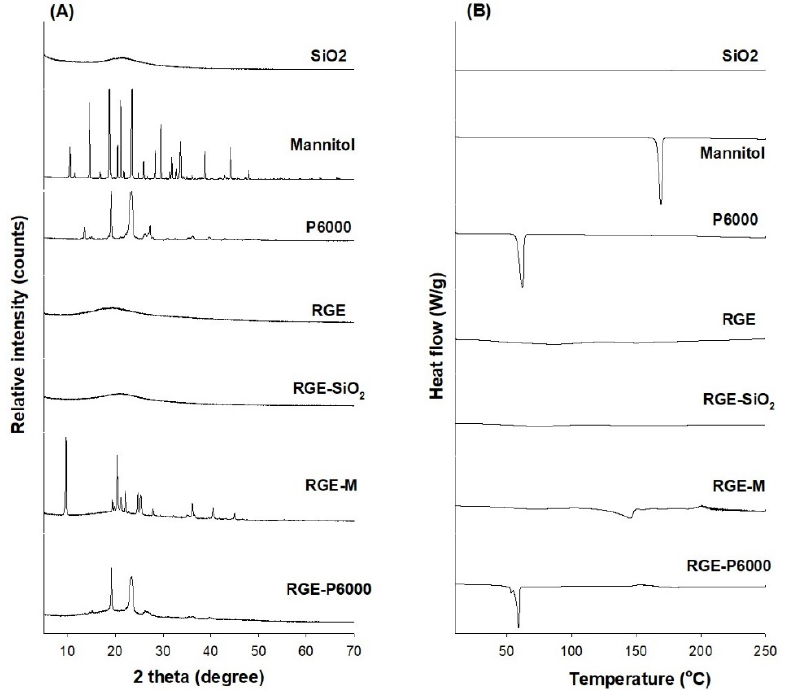
Figure 5. ( A ) The X-ray diffraction patterns and ( B ) the differential scanning calorimetry thermo- grams of SiO 2 , mannitol, P6000, red ginseng extract (RGE), RGE-SiO2, RGE-M, and